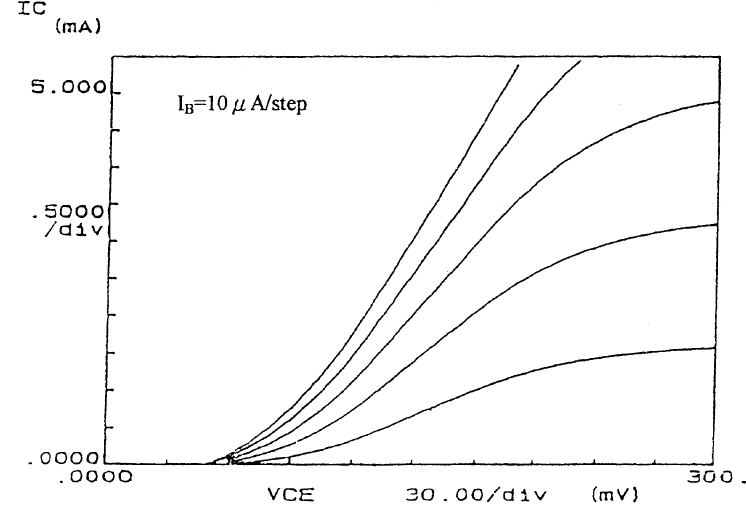
FIGURE 4 The offset voltage as low as 50mV in common emitter configuration shown in low voltage